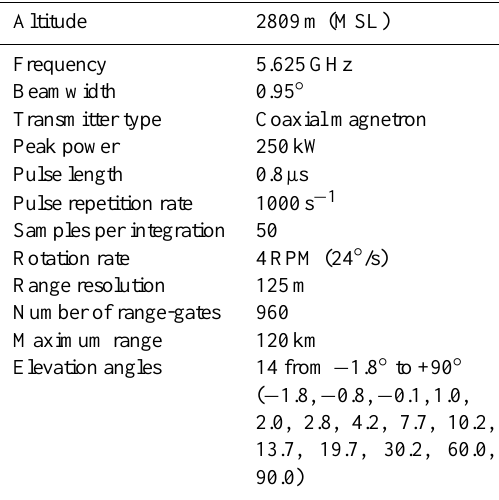
Table 1. Characteristics of the Valluga radar during test